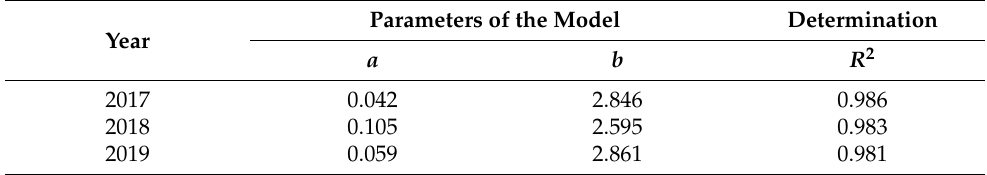
Table 3. The parameter’s value of the model used for biomass